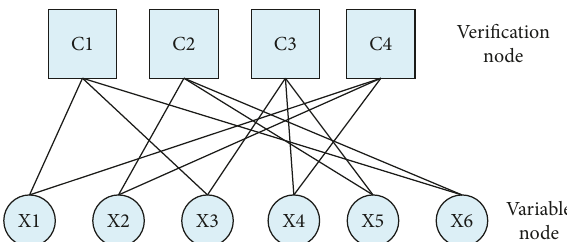
Figure 8: Tanner diagram of the LDPC code under the condition of λ � 2 and c �